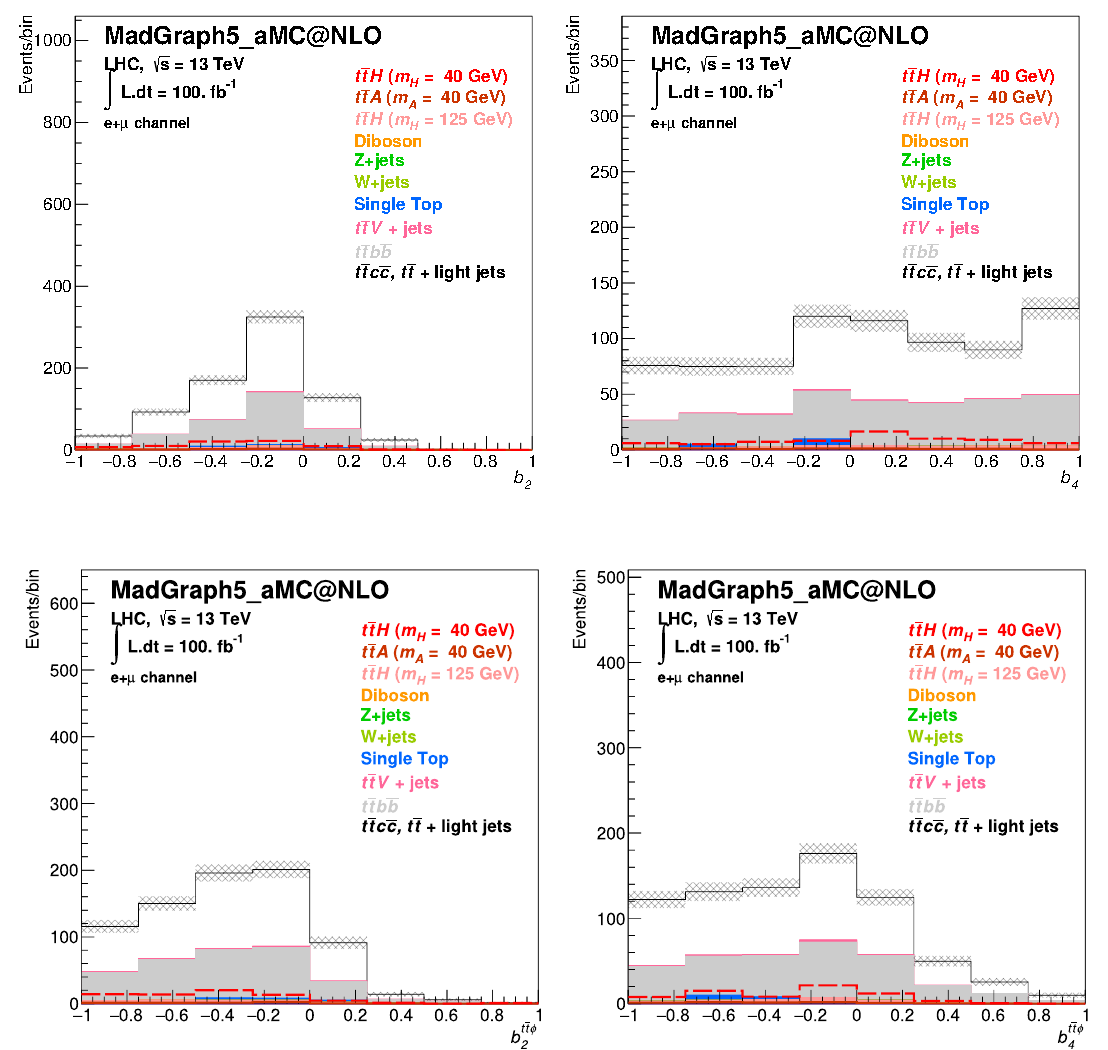
Figure 13. Expected number of background and signal events for the distributions b 2 (top left), b 4 (top right), b t (cid:22) t(cid:30) (bottom left) and b t (cid:22) t(cid:30) (bottom right), for a luminosity of 100 fb (cid:0) 1 . 2 4